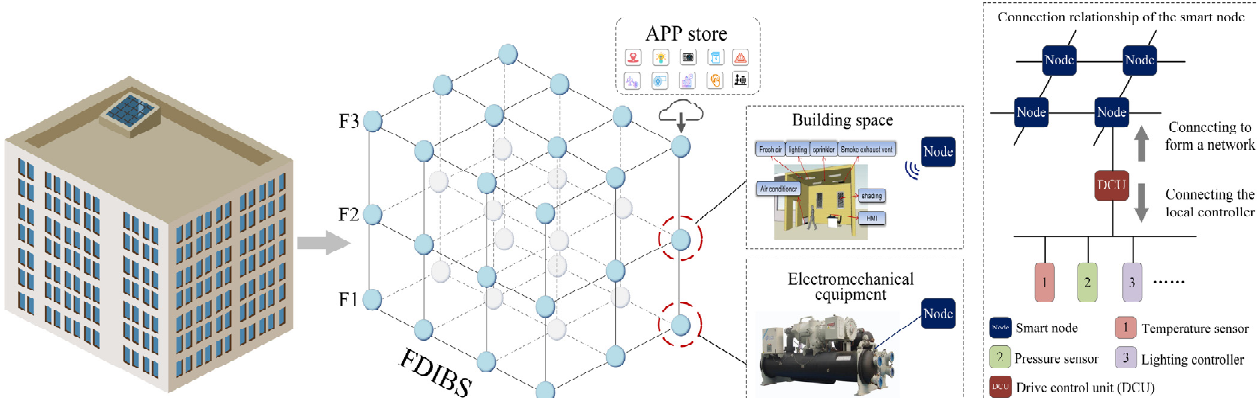
Figure 1. Fully distributed intelligent building